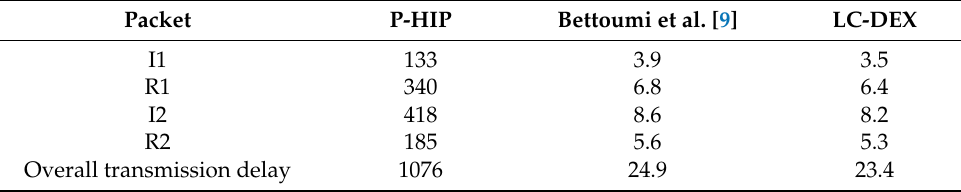
Table 8. Comparison of handshake’s transmission delay (ms) with P-HIP and Bettoumi et al. [9].